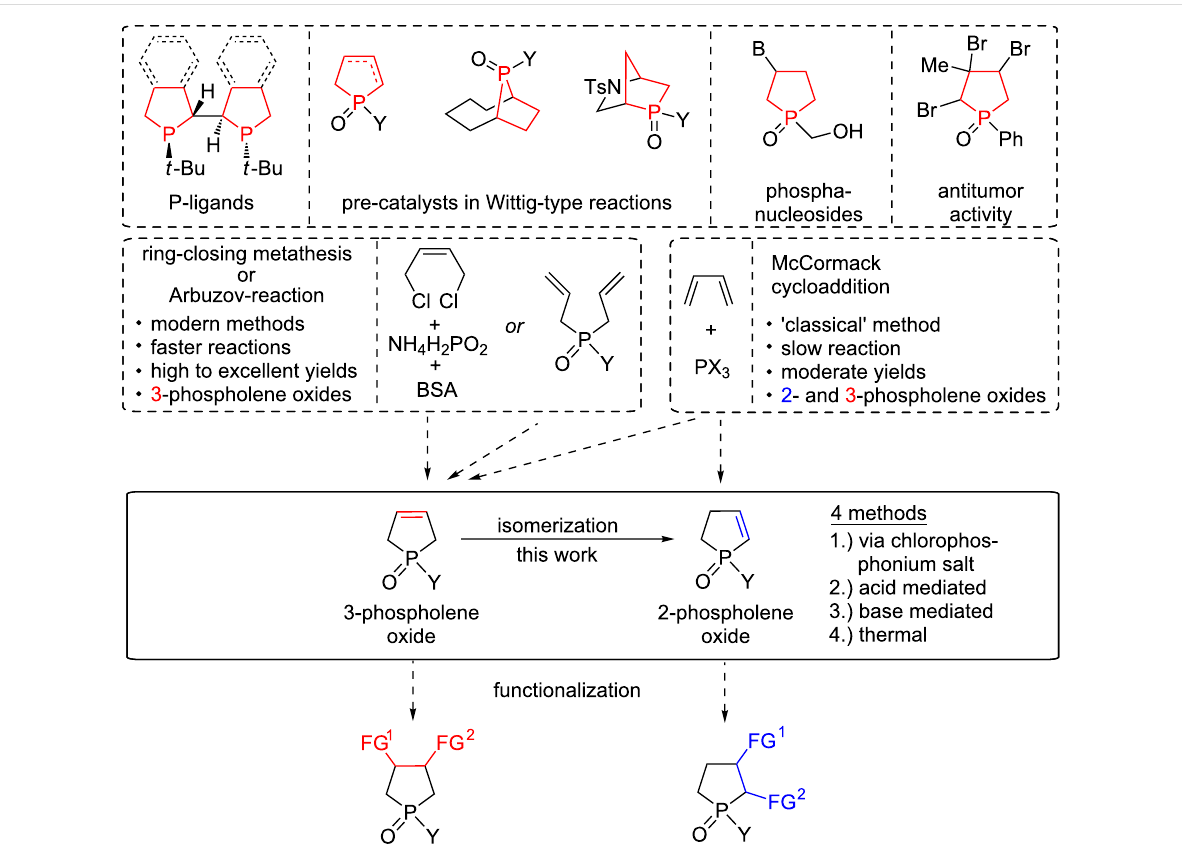
Figure 1: Examples for catalytically or biologically active molecules containing five-membered P-heterocyclic rings. General strategies for the prepara- tion and functionalization of 2- and 3-phospholene